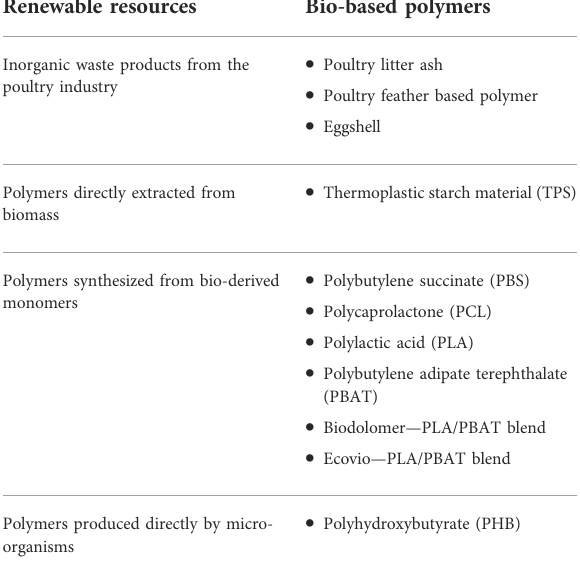
TABLE 1 The bio-based polymers based on their different renewable resources. Renewable